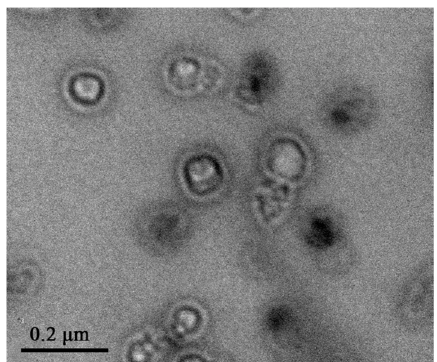
Figure 12. TEM image of the nanolipogel prepared by Zhang and coworkers. Reprinted with permission from Reference [82]. Copyright (2018) American Chemical Society.